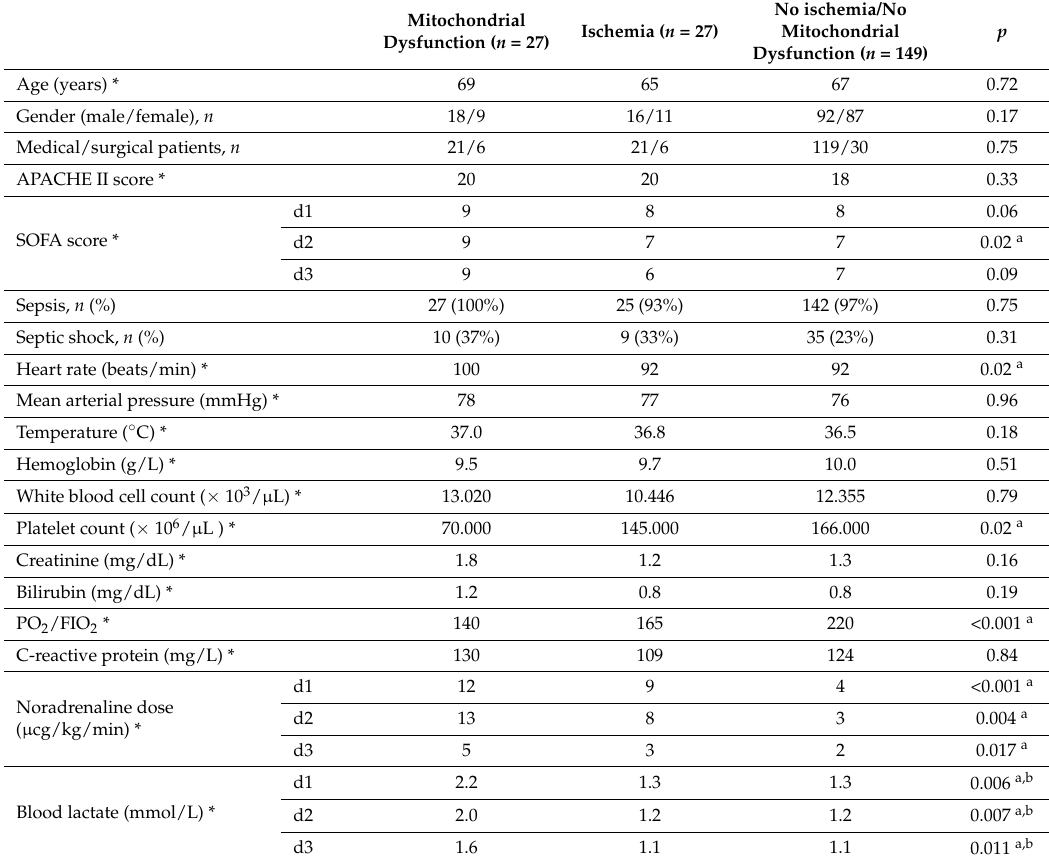
Table 1. Clinical characteristics and laboratory data in groups defined as mitochondrial dysfunction, ischemia, and no ischemia/no mitochondrial